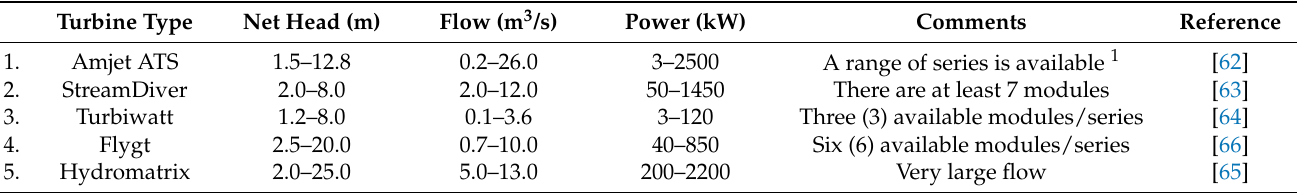
Table 6. Main features of modular turbines currently available on the market and suitable for in-conduit hydropower in a low-head